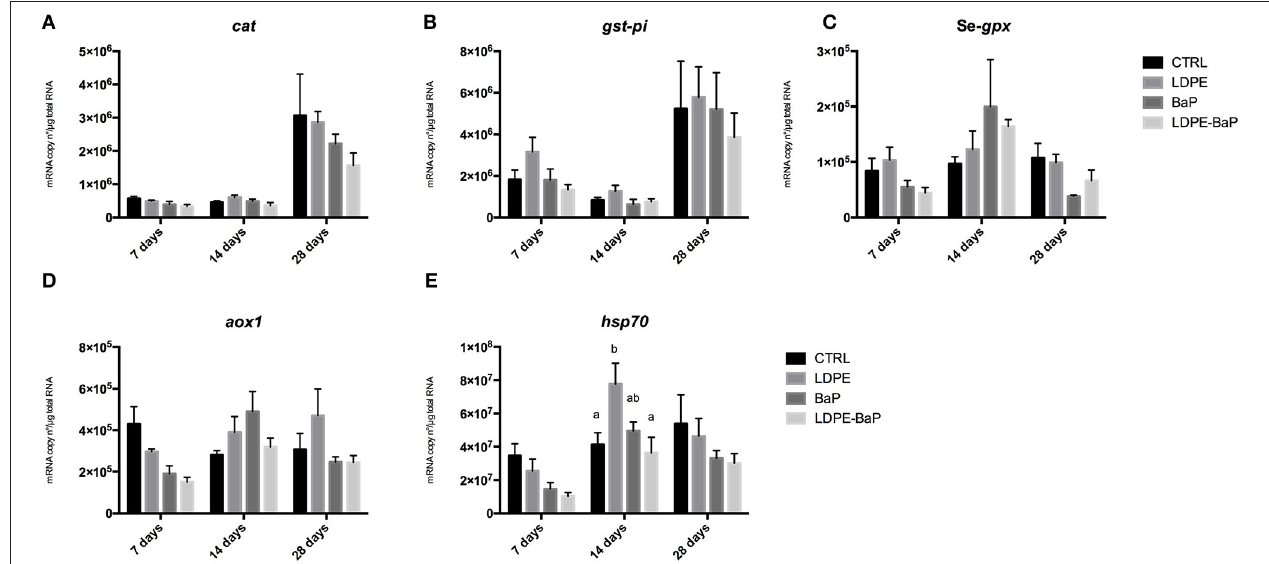
FIGURE 6 | Transcriptional responses in the digestive glands of mussels exposed for 7, 14, and 28 days to various treatments (CTRL, control; LDPE, virgin low density polyethylene; BaP, benzo(a)pyrene alone; LDPE-BaP, benzo(a)pyrene-contaminated polyethylene). cat , catalase (A) ; gst-pi , pi -class glutathione S-transferase (B) ; Se-gpx , selenium-dependent glutathione peroxidase (C) ; aox1 , acyl-CoA oxidase, isoform 1 (D) ; hsp70 , heat shock protein 70 (E) . Data are expressed as mean values ± standard error, n = 4; different letters indicate significant differences between groups of means within the same time of exposure ( post-hoc Newman-Keuls